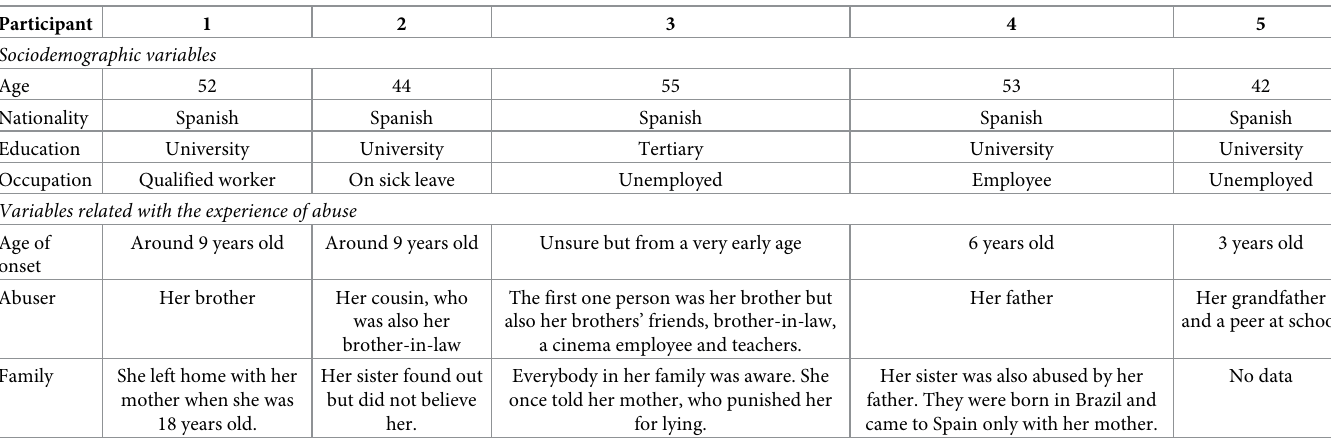
Table 1. Participants who were victims of CSA (Study I and Study